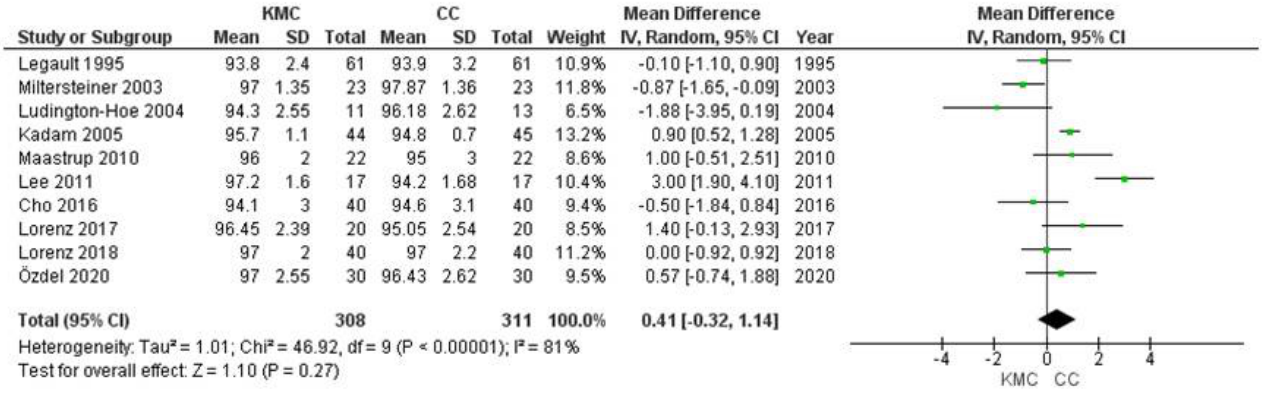
Figure 6. Forest plots for effects of KMC compared with conventional care on oxygen saturation (%).